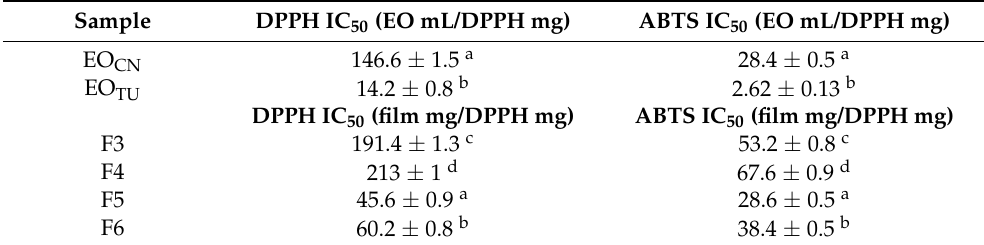
Table 5. Antioxidant activity of cinnamon (EO CN ) and turmeric EOs (EO TU ).